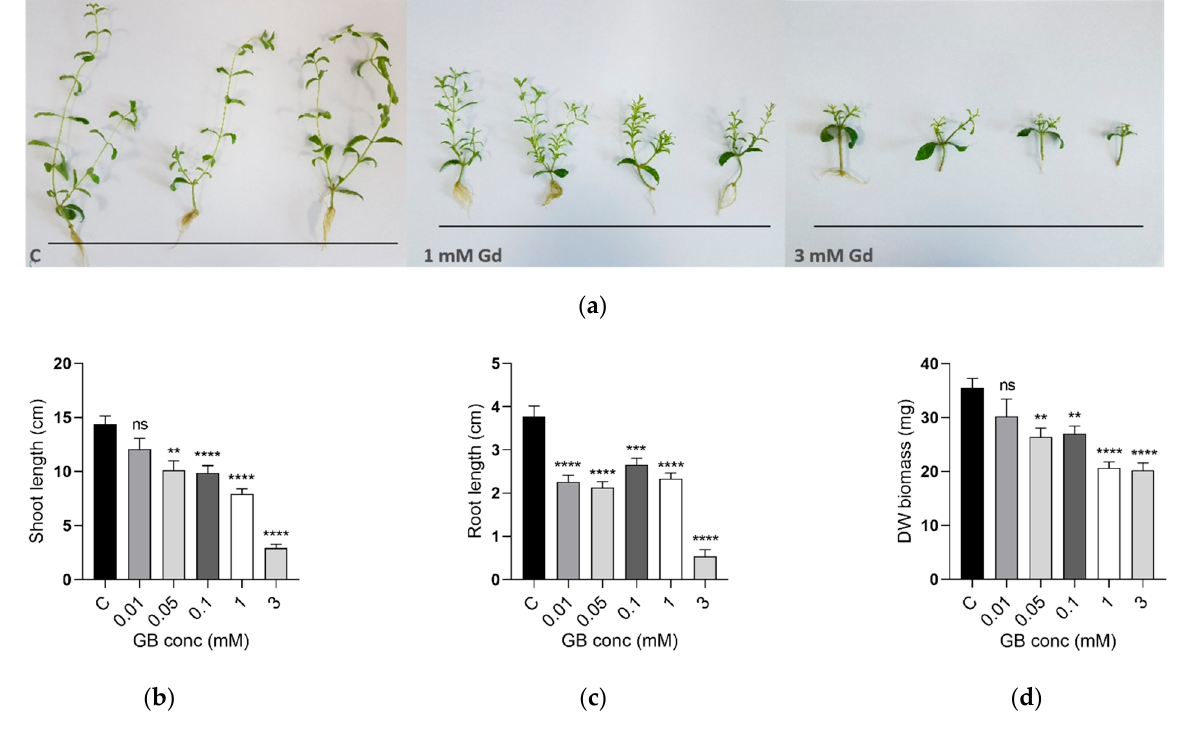
Figure 1. Top : ( a ) S. rebaudiana plants after being grown for 28 days in control growth media and media exposed to 1 mM and 3 mM gadobutrol (from left to right ); Bottom : ( b ) mean and SE shoot length ( n = 30), ( c ) mean and SE root length ( n = 30) and ( d ) mean and SE dry weight plant biomass ( n = 30) of S. rebaudiana plants after being exposed for 28 days to different concentrations of gadobutrol of 0–3 mM. (ns for p -value range > 0.05; ** for p -value range 0.001–0.01; *** for p -value range 0.0001–0.01; **** for p -value range < 0.0001)